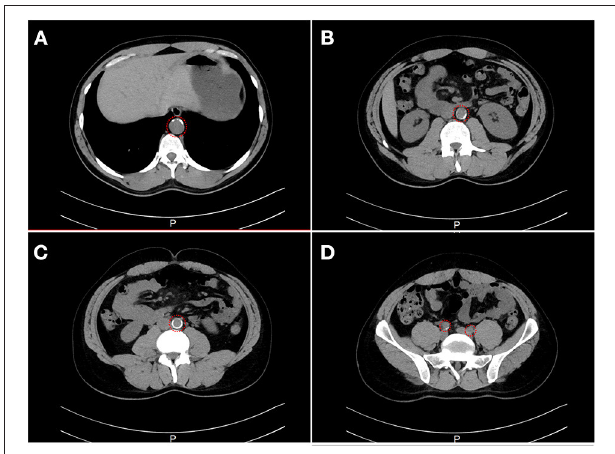
FIGURE 2 | A computerized tomography (CT) scan showing the evidence of stenosis. CT cross-section of the thoraco-abdomen illustrating (A) Calcification within the aortic wall in the thoracic region (T11–T12). (B) Calcification within the aortic wall in the lumber region (L1–L2). (C)